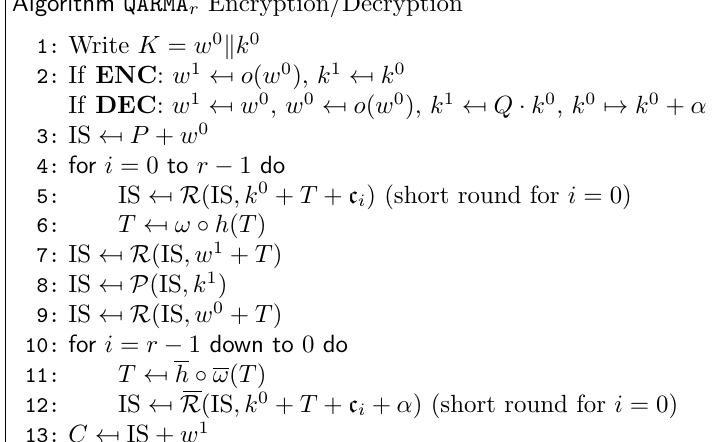
Algorithm QARMA r